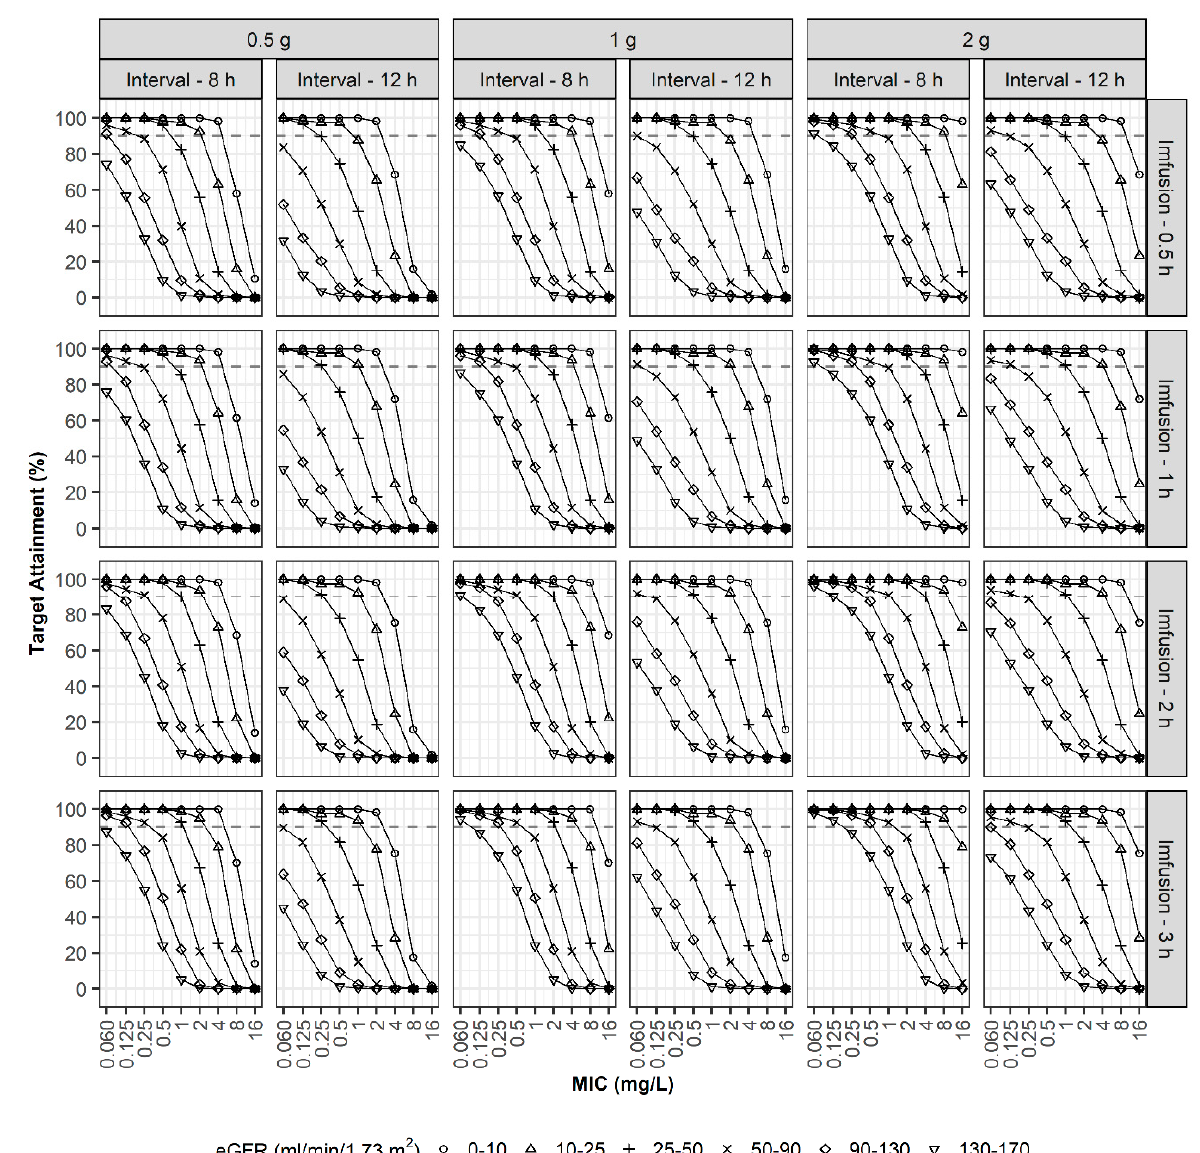
Figure 6. PTAs (100% f T >4XMIC ). Simulation results with three doses (0.5, 1, and 2 g), two dosing intervals (8 and 12 h), four infusion times (0.5, 1, 2, and 3 h), various degrees of renal function, and various MICs.